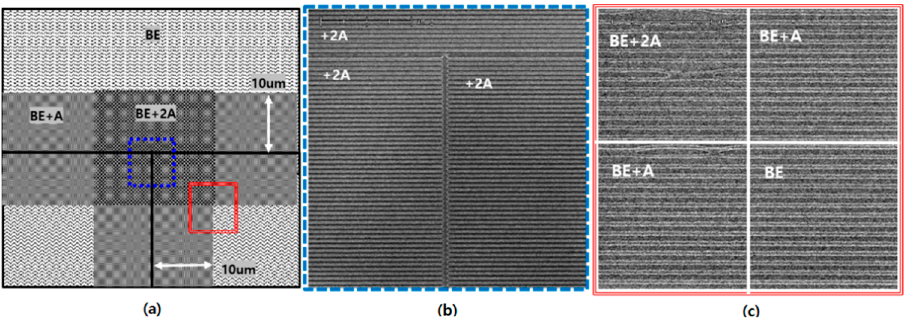
Figure 5. ( a ) Schematic of shot field boundary after OPC. CD_SEM (Scanning Electron Microscope) image of ( b ) the blue dotted line and ( c ) the red solid line.